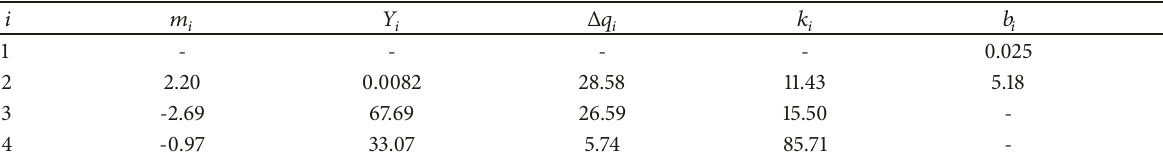
Table 1: The values of parameters